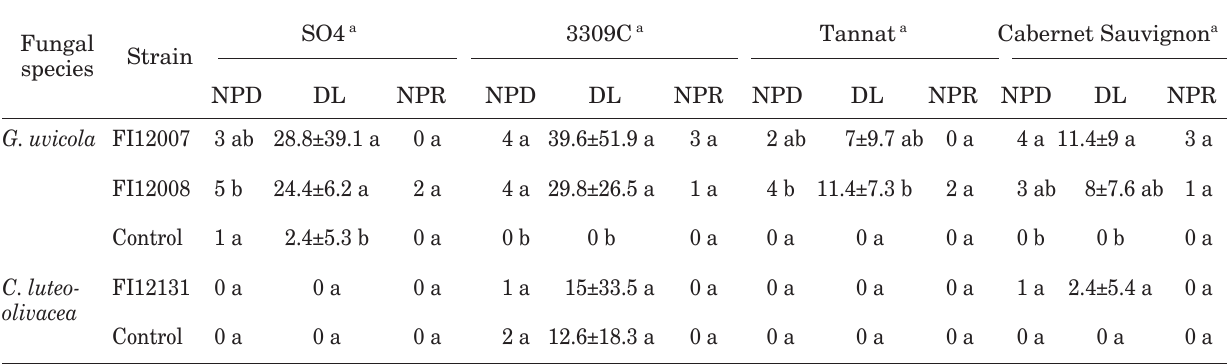
Table 2. Mean pathogenicity parameters measured in a trial where Greeneria uvicola and Cadophora luteo-olivacea were inoculated onto different grapevine rootstocks and scion cultivars.